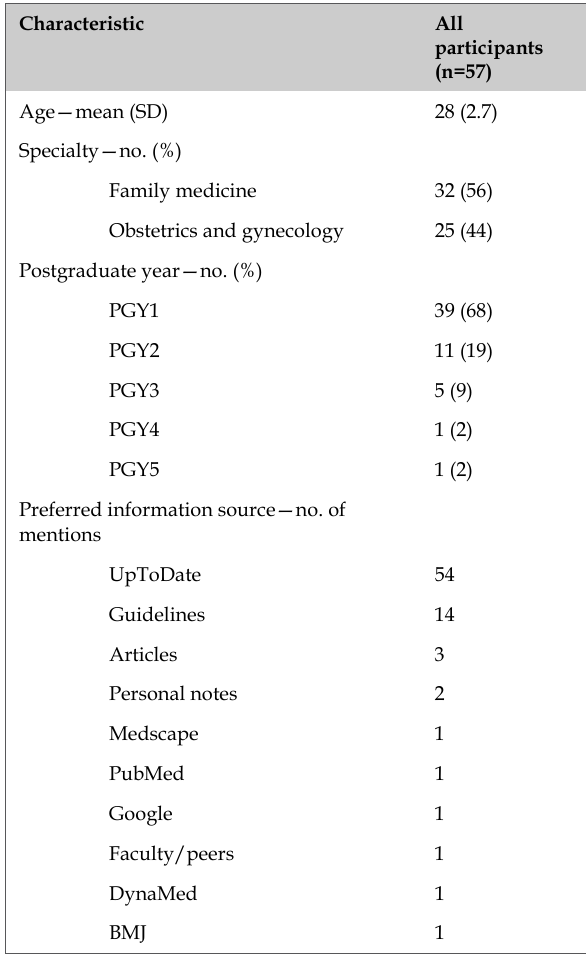
Table 1 Baseline demographic characteristics of